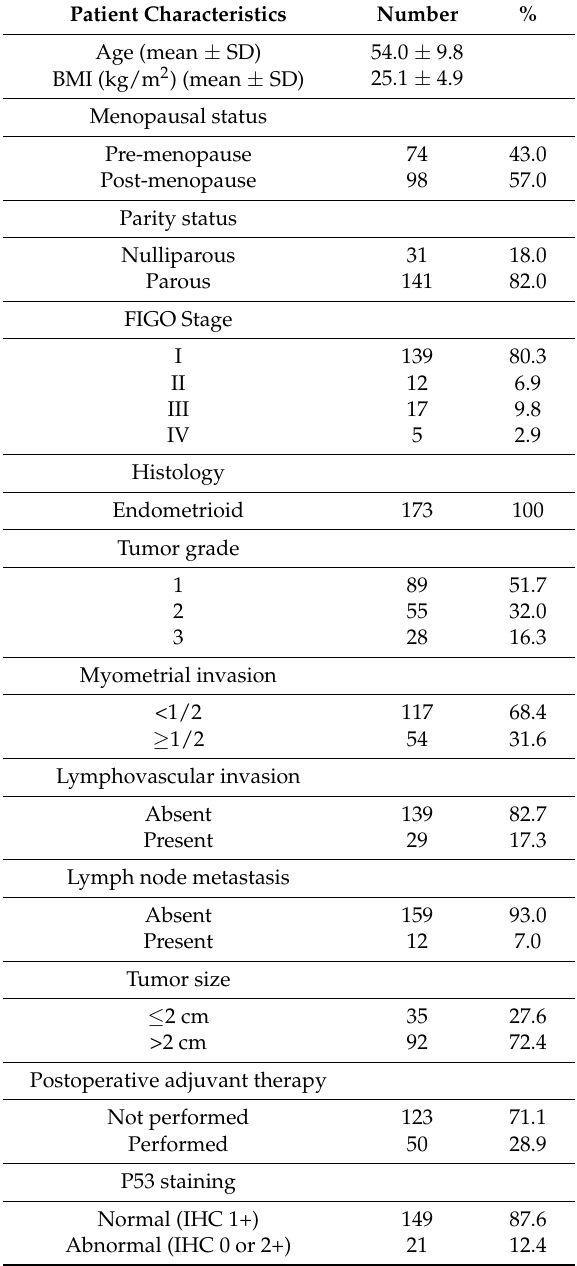
Table 1. Baseline clinical and pathologic characteristics of the study